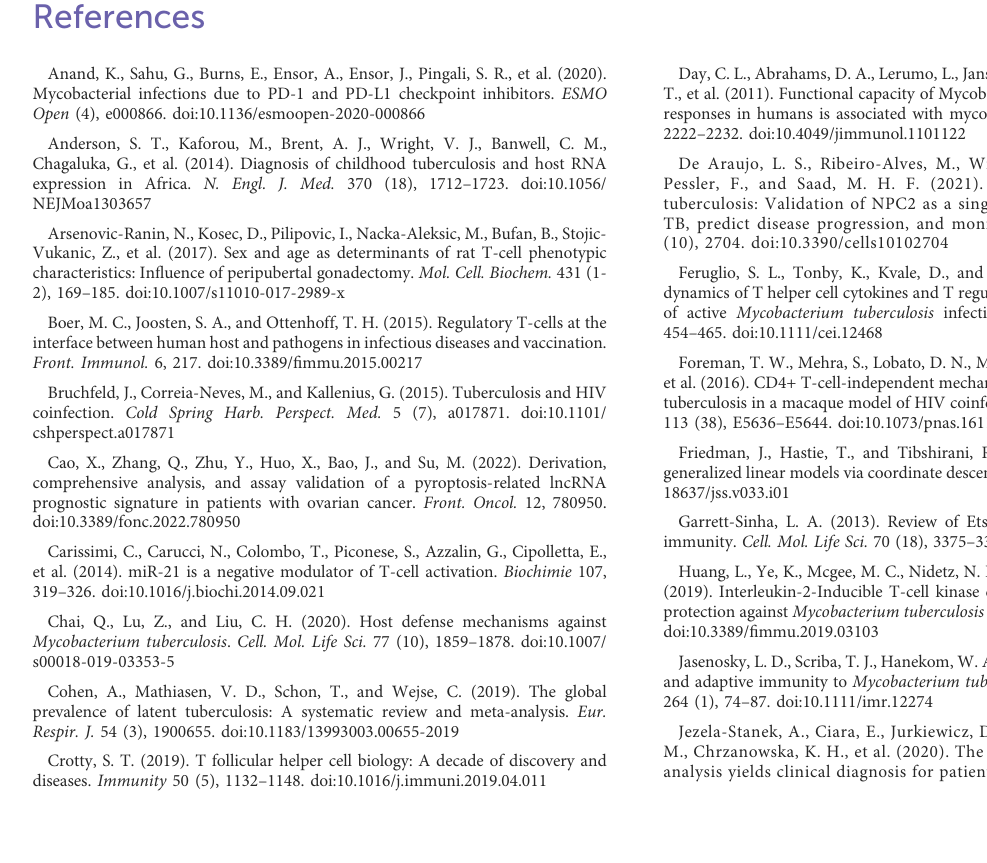
SUPPLEMENTARY FIGURE S3 Comparision of critical T cells abundance between active and latent